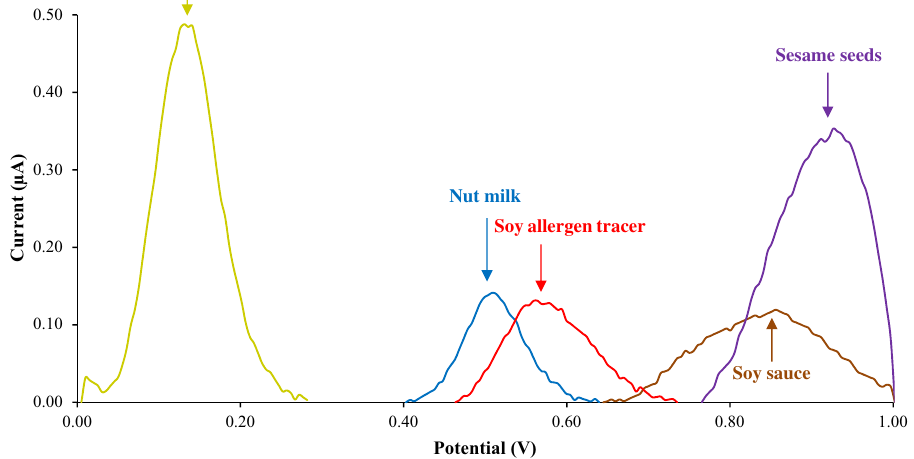
Figure 2. DPV responses for soy allergen tracer (red line), soy sauce (brown line), sesame seeds (purple line), coffee (gold line), nut milk (blue line) 10% by weight in buffer solution containing 10% ethanol in 90% PBS